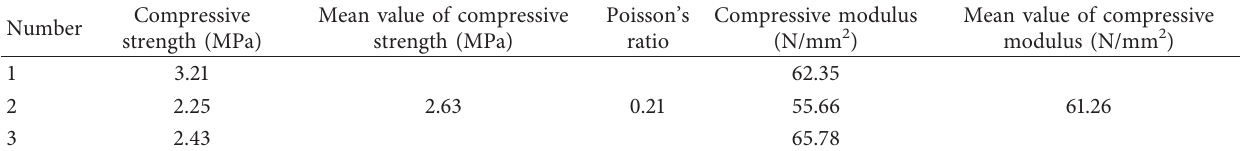
Table 2: Mechanical properties of the modified slurry.